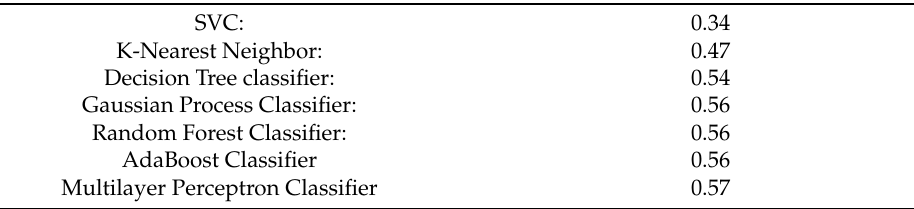
Table 2. Sample of six Machine Learning models predicting SVC